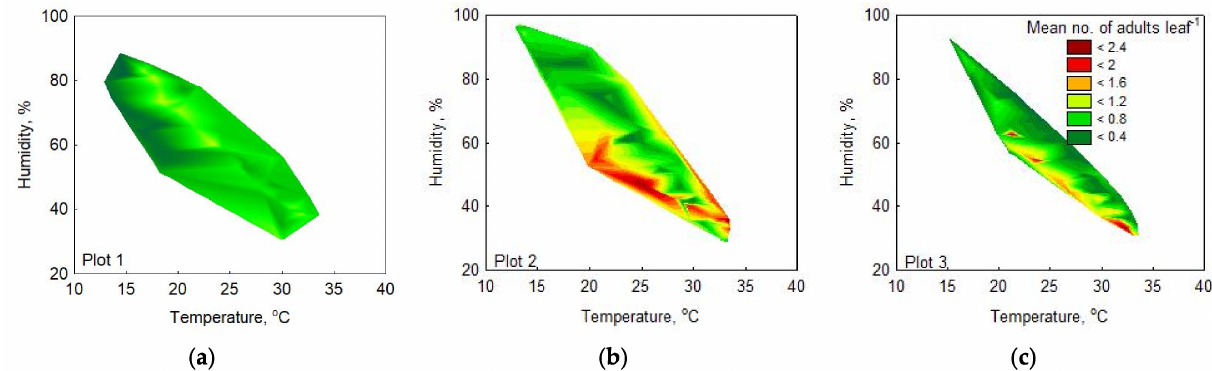
Figure 6. Intensity of OLB activity along a gradient of meteorological conditions for all three studied periods in the three plots: ( a ) Plot 1 (S tef ă nes ti); ( b ) Plot 2 (Incinta); ( c ) Plot 3 (Ceag ă , ,